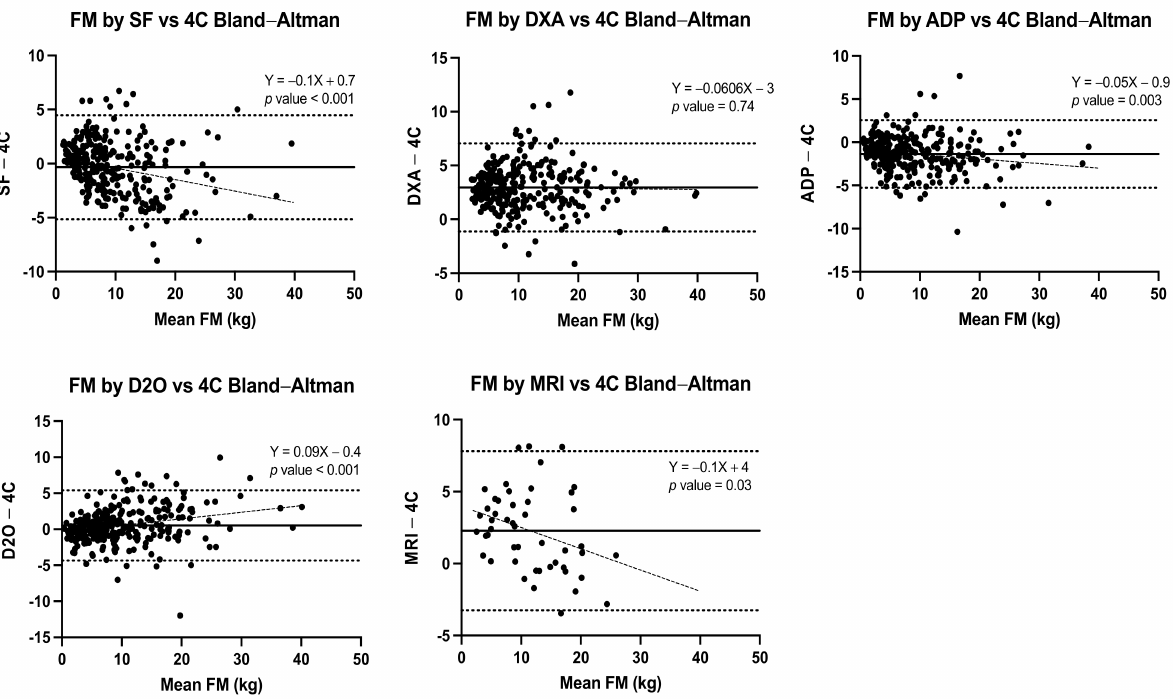
Figure 1. Bland–Altman plots for FM estimation by SF, DXA, ADP, D 2 O, and MRI in contrast with the 4-C model for the total sample. A positive trend indicates an increasing underestimation of FM at high FM levels; a negative trend indicates an increasing overestimation of FM at high FM